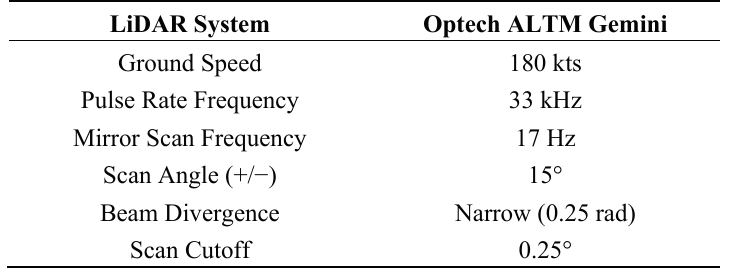
Table 1. Specifications of Kenai airborne LiDAR data